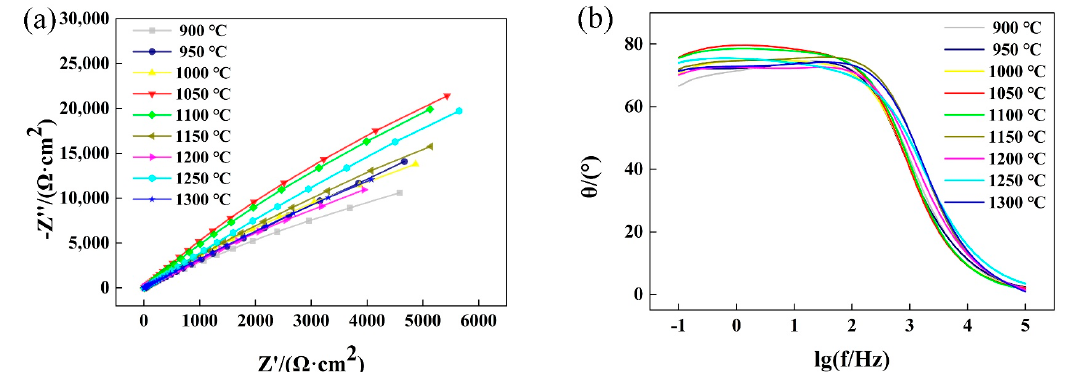
Figure 14. Electrochemical impedance spectroscopy (EIS) diagrams of UNS S32750 duplex stainless steel treated at different solution treatment temperatures. ( a ) Nyquist plot; ( b ) Bode plot.